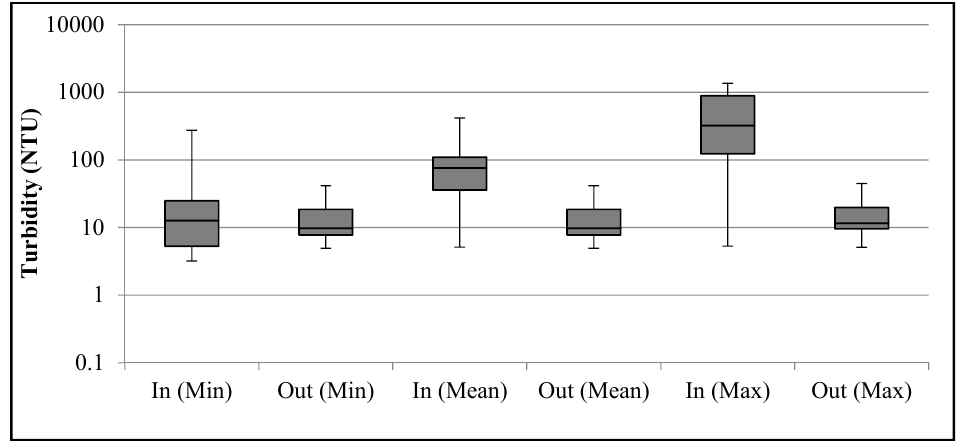
Figure 9. Summer inlet and outlet turbidity during runoff events: minimum, mean and maximum.